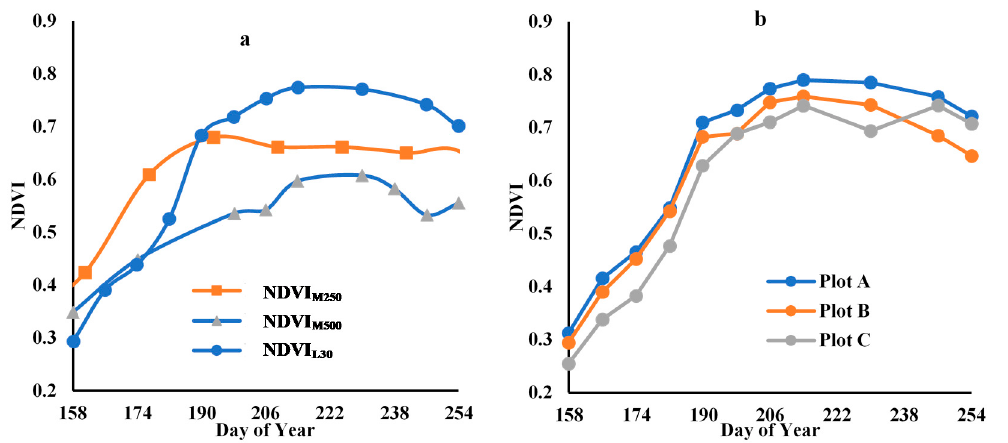
Figure 8. Time-series NDVI curve ( a ) NDVI M500 , NDVI M250 , and NDVI L30 ; ( b ) NDVI L30 of the three cotton plots).